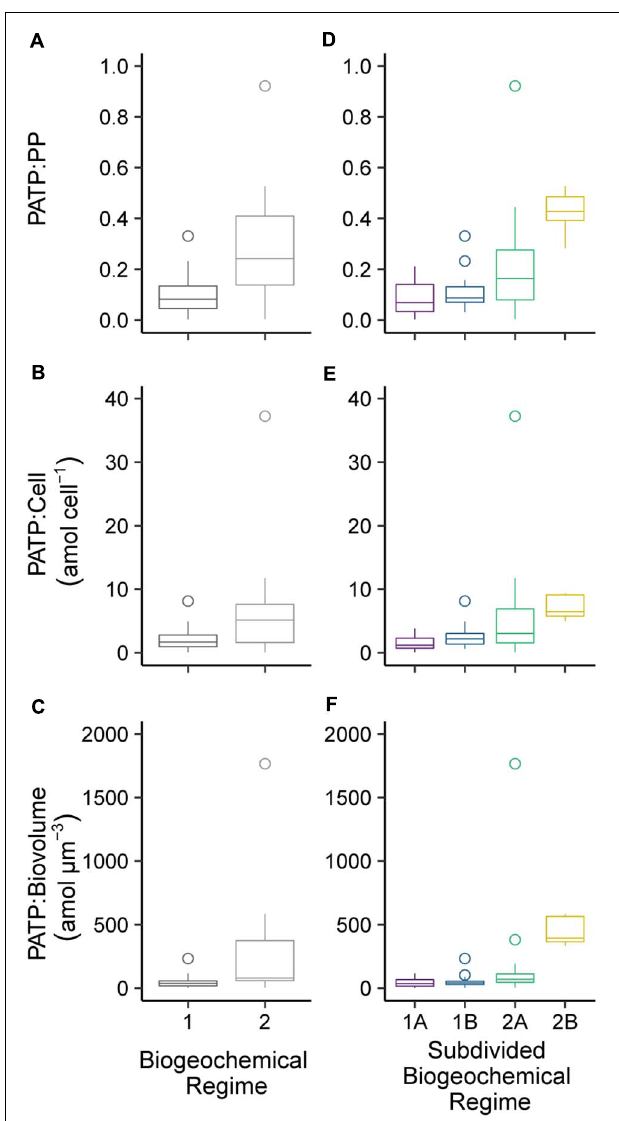
FIGURE 5 | Comparison of the median particulate adenosine triphosphate (PATP) concentrations normalized to (A) particulate phosphorus (PP) concentration, (B) total microbial abundances (Cell), and (C) estimated total microbial biovolume (Biovolume) between the combined biogeochemical regimes 1A and 1B to the combined regimes 2A and 2B. A comparison of PATP normalized to (D) PP, (E) Cell, and (F) Biovolume between the four subdivided biogeochemical regimes (1A, 1B, 2A, 2B). The boxplot whiskers extend to 1.5 times the interquartile range of the data points and outliers were plotted as